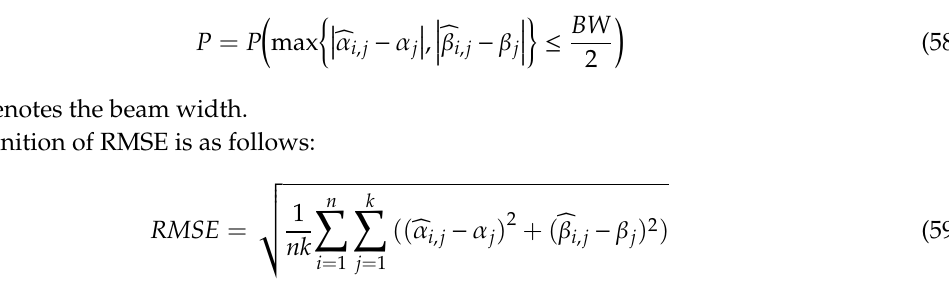
Figure 4. Comparison of complexity versus the number of snapshots.